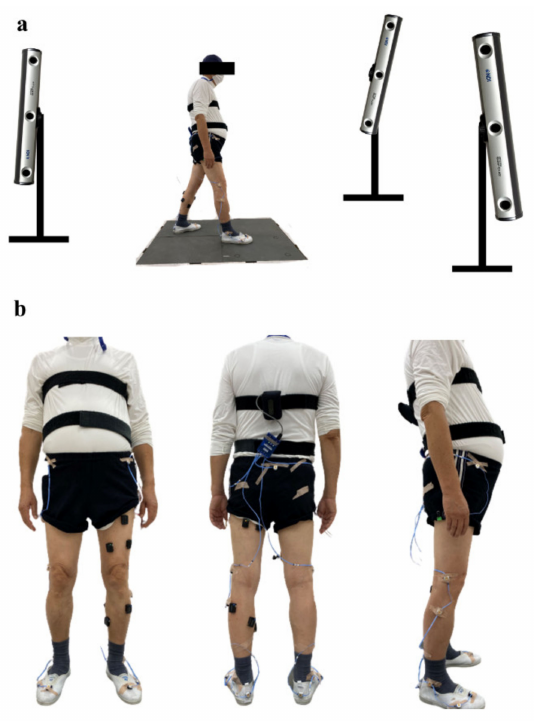
Figure 1. Motion analysis position sensor and marker placement: ( a ) position sensor placement: posterior, left anterior, and right anterior to the walkway, and ( b ) lower extremity marker placement: anterior, posterior, and lateral